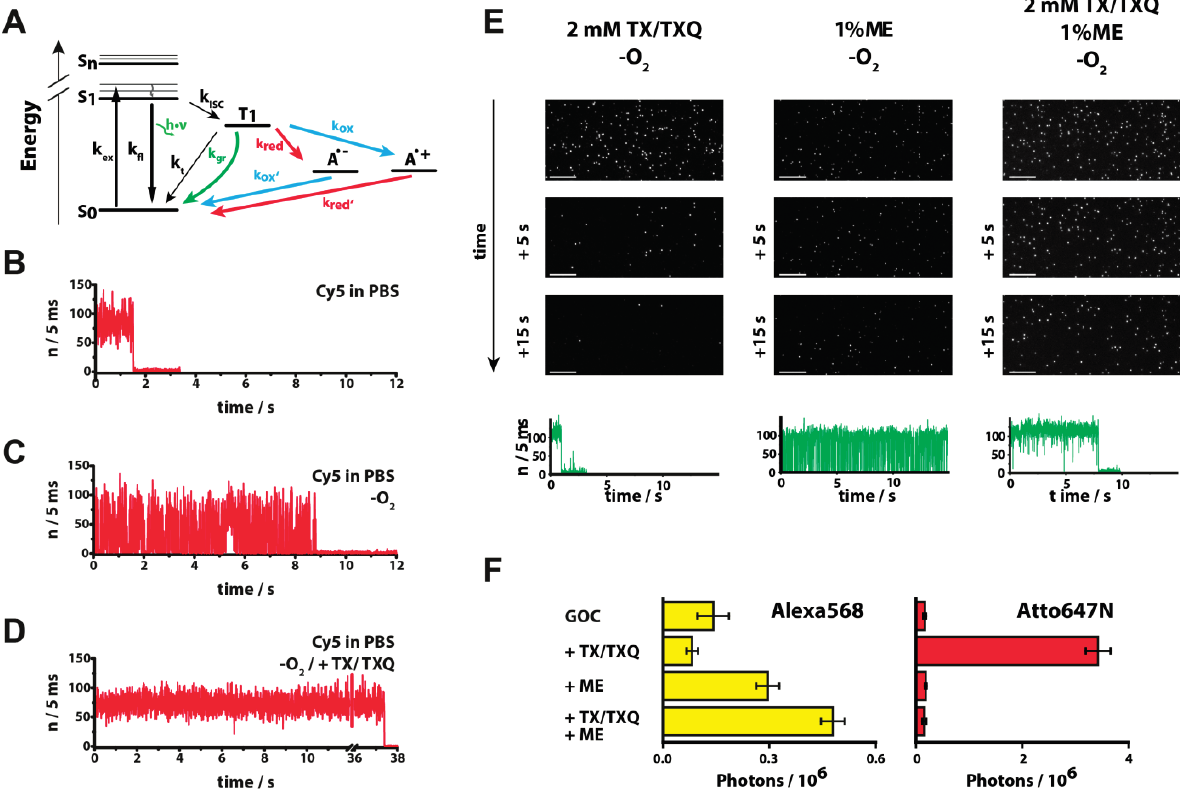
Figure 2. ( A ) Jablonski diagram: once an organic dye absorbs a photon it is excited from the ground state S 0 to the first excited singlet state S 1 (k ex ) and can return to S 0 by emission of a photon (k fl , fluorescence ). The dye can undergo numerous excitation-emission cycles before it enters a non-fluorescent triplet state T 1 via intersystem crossing (k ISC ). Once in the triplet state, the dye can either return directly to S 0 (k t ) via different, competing pathways or can be destroyed by singlet oxygen (photobleaching). The reduction of the dye in its triplet state to a non-fluorescent radical anion A − (k red , red), which can subsequently be oxidized (k ox , blue) promotes the depopulation of T 1 to S 0 . The depopulation of the triplet state can also start with the oxidation reaction followed by the reduction step; ( B – D ) Exemplary photophysical behavior of organic dyes. Fluorescence transients of Cy5-labeled dsDNA in aqueous PBS buffer (B). The removal of oxygen leads to reduced triplet quenching and increased blinking. (C) Addition of 2 mM Trolox(TX)/Troloxquinone (TXQ) enables stable and prolonged fluorescence over minutes (D). Photostabilization by the “geminate recombination” mechanism [48] ( E ). A time series of frames showing the photostability of Alexa568 dyes in different buffers (2 mM TX/TXQ, left column; 1% beta-mercaptoethanol (ME; center), and a combination of both (right column)), oxygen was removed in all cases (see text for details). Scale bar: 10 μ m. The last row shows transients from a confocal microscope that illustrate the differences in blinking and photobleaching behavior of the dye. (F ) Total number of detected photons before photobleaching or long-lived dark states for the dyes Alexa568 and ATTO647N in different buffers (figures in panel A, E and F adapted by permission from Holzmeister et al. , Geminate recombination as a photoprotection mechanism for fluorescent dyes, Angewandte Chemie,